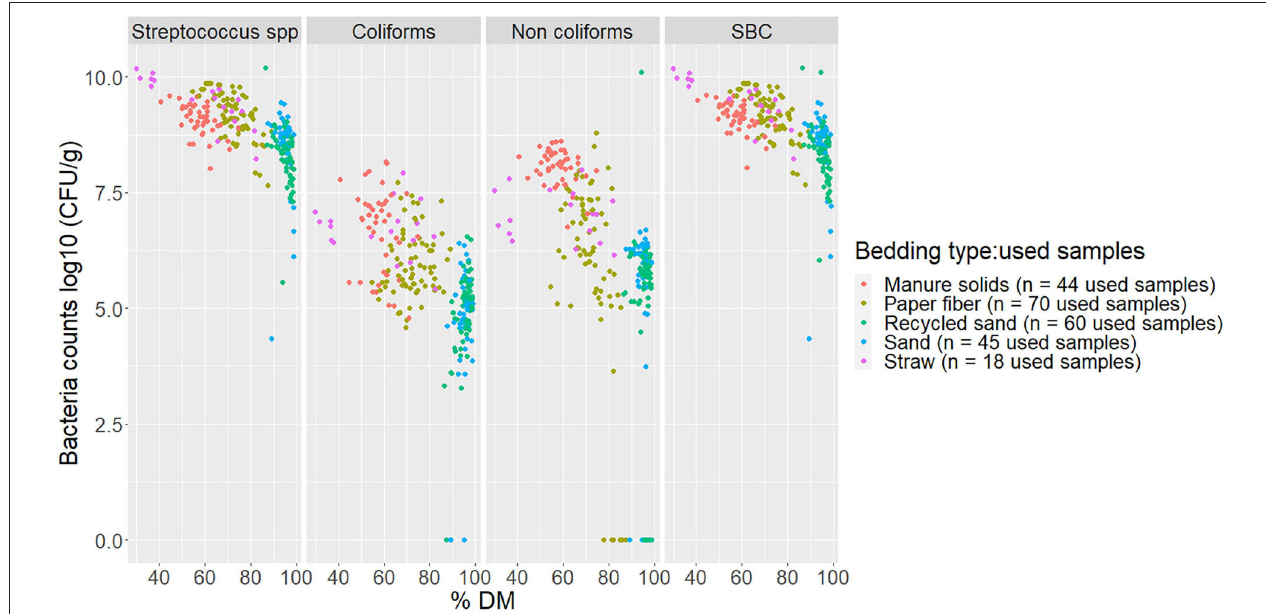
FIGURE 6 | Scatterplot of DM content (% DM) vs. bacteria counts (log10 CFU/g) by bacteria group and bedding type in used bedding samples collected from July 2018 to July 2019 from five conveniently selected New York dairy herds using one of five bedding materials in lactating pens. Three to five used bedding samples were collected monthly following an SOP at each visit (unless there was no bedding available due to lack of supply or equipment malfunction on the follow-up visit). When no bacteria were identified, a value of log 10 + 1 CFU/g was given, assuming that at least 10 CFU were present. SBC (sum bacterial count) = Streptococcus spp, coliforms and non-coliforms summed.